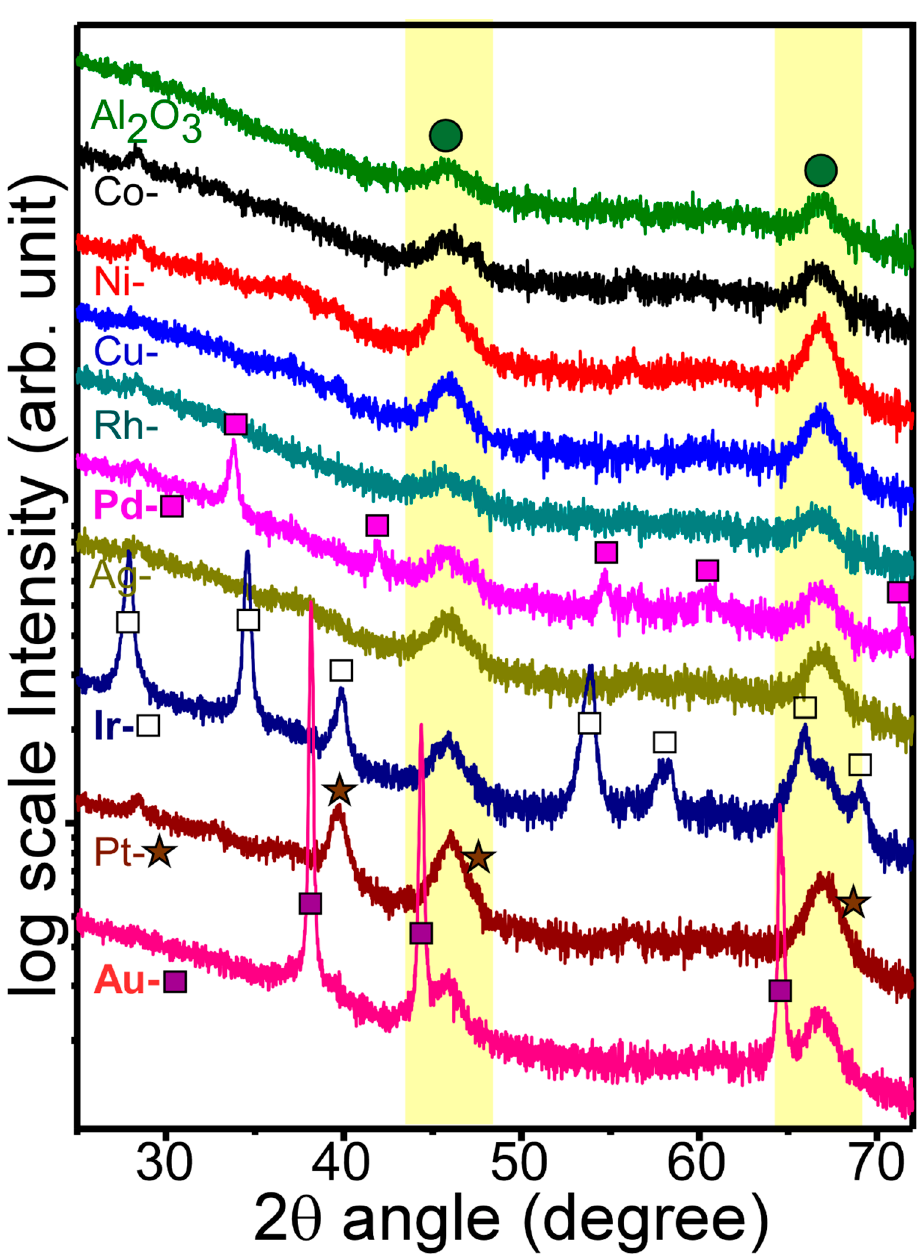
Figure 3. XRD profiles bare Al 2 O 3 and M-loaded Al 2 O 3 nanosheets. XPS was employed to confirm the loading of the transition metals and examine the oxidation states. Figure 4 shows Co 2p, Ni 2p, Cu 2p, Rh 3d, Pd 3d, Ag 3d, Ir 4d, Pt 4d, and Au 4d of Co-Al 2 O 3 , Ni-Al 2 O 3 , Cu-Al 2 O 3 , Rh-Al 2 O 3 , Pd-Al 2 O 3 , Ag-Al 2 O 3 , Ir-Al 2 O 3 , Pt-Al 2 O 3 , and Au-Al 2 O 3 nanosheets, respectively. XPS valence band spectra (Figure 4,